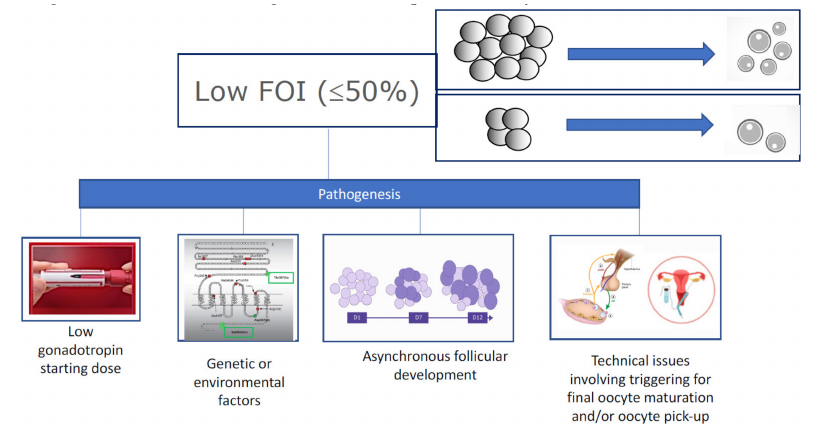
Figure 2. Pathogenesis of low follicle-to-oocyte index (FOI). Reprint from: Alviggi, C.; Conforti, A.; Esteves,S.C.;Vallone,R.;Venturella,R.;Staiano,S.;Castaldo,E.;Andersen,C.Y.;DePlacido,G.Understanding Ovarian Hyporesponse to Exogenous Gonadotropin in Ovarian Stimulation and Its New Proposed Marker—The Follicle-To-Oocyte (FOI) Index. Front. Endocrinol. (Lausanne) 2018 , 9 , 589. This is